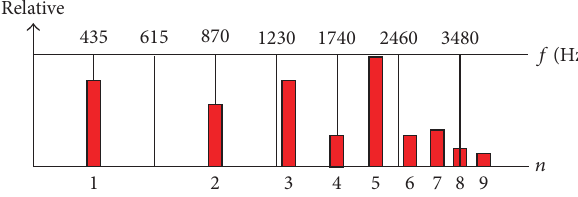
Figure 1: Fourier spectrum of a violin string